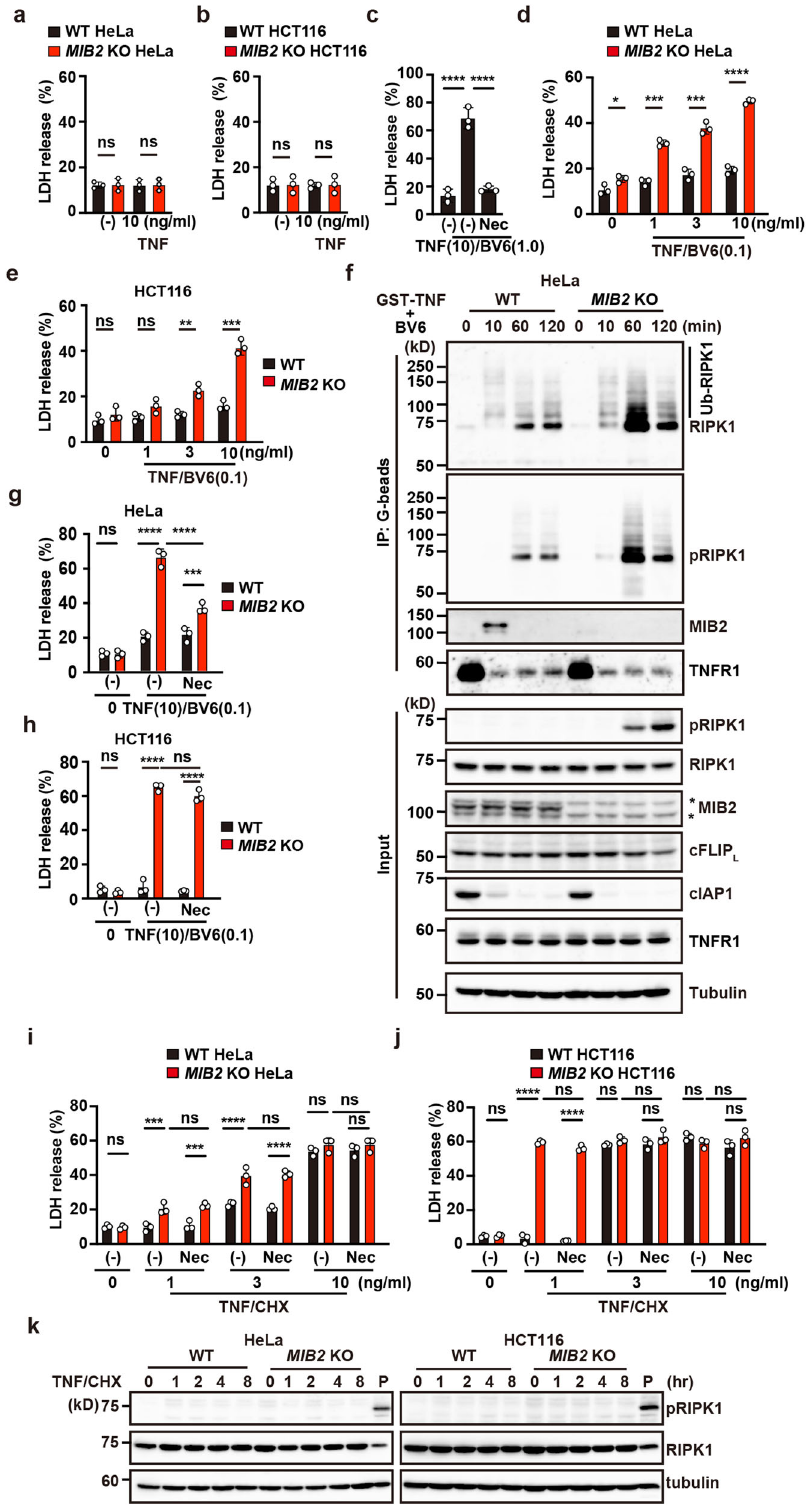
RIPK1 kinase activity-dependent and -independent apoptosis are enhanced in MIB2 KO cells . Next, we investigated whether TNF-induced apoptosis was enhanced in MIB2 KO HeLa cells. In contrast to C fl ar -de fi cient murine embryonic fi broblasts (MEFs) that undergo apoptosis upon TNF treatment alone 19 , TNF did not induce apoptosis in WT and MIB2 KO cells (Fig. 6a, b). In